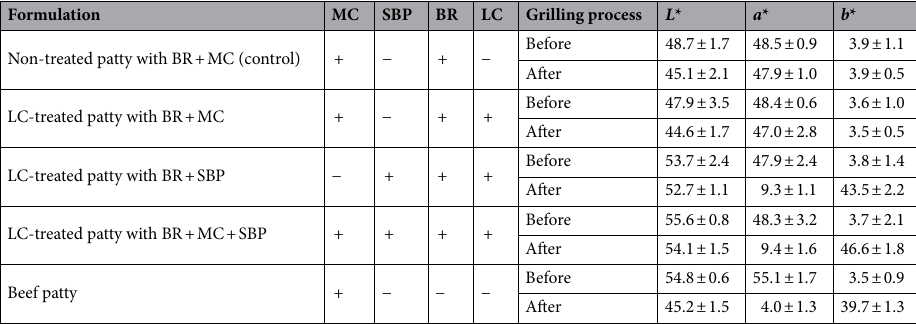
Table 1. Objective color measurements ( L * a * b *) coordinates of plant-based and animal-based